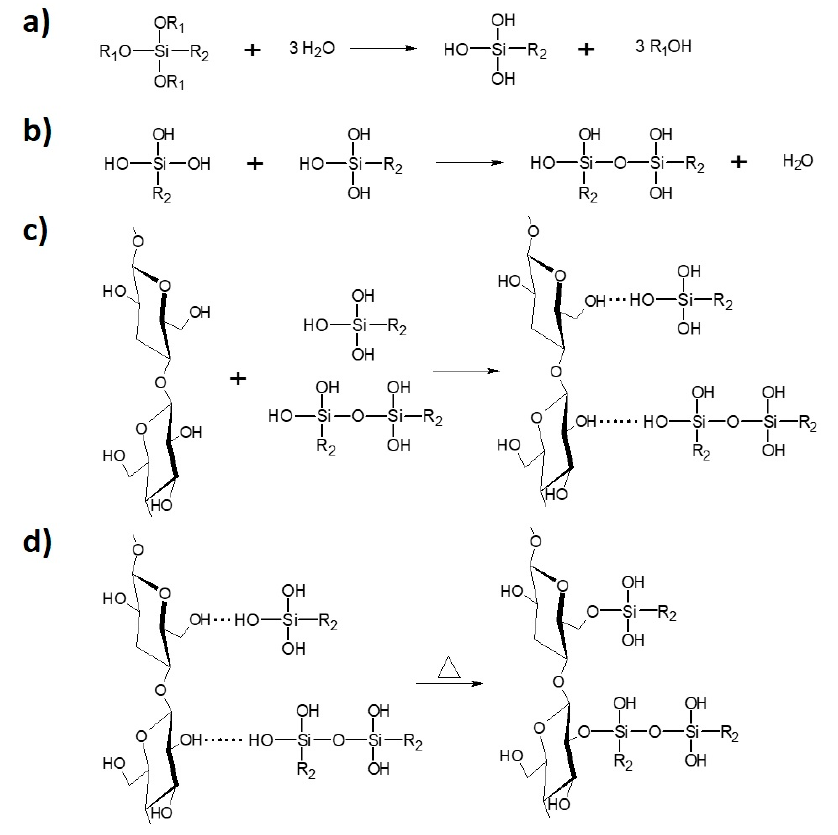
Figure2. Cellulosemodificationwithsilanecouplingagent: ( a )hydrolysis; ( b )condensation; ( c )physical Figure 2. Cellulose modification with silane coupling agent: ( a ) hydrolysis; ( b ) condensation; ( c ) adsorption; ( d ) chemical grafting physical adsorption; ( d ) chemical grafting [31].